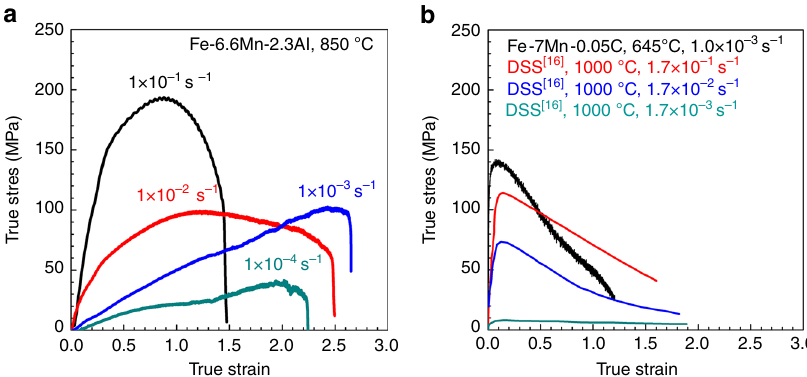
Fig. 3 True stress – strain curves of medium Mn steels and a duplex stainless steel with dual-phase microstructures of ferrite and austenite at high temperatures. a Fe-6.6Mn-2.3Al (wt.%) steel. b Fe-7Mn-0.05C (wt.%) steel and a highly alloyed duplex stainless steel (DSS, Fe-25Cr-7Ni-3Mo-0.14N 16